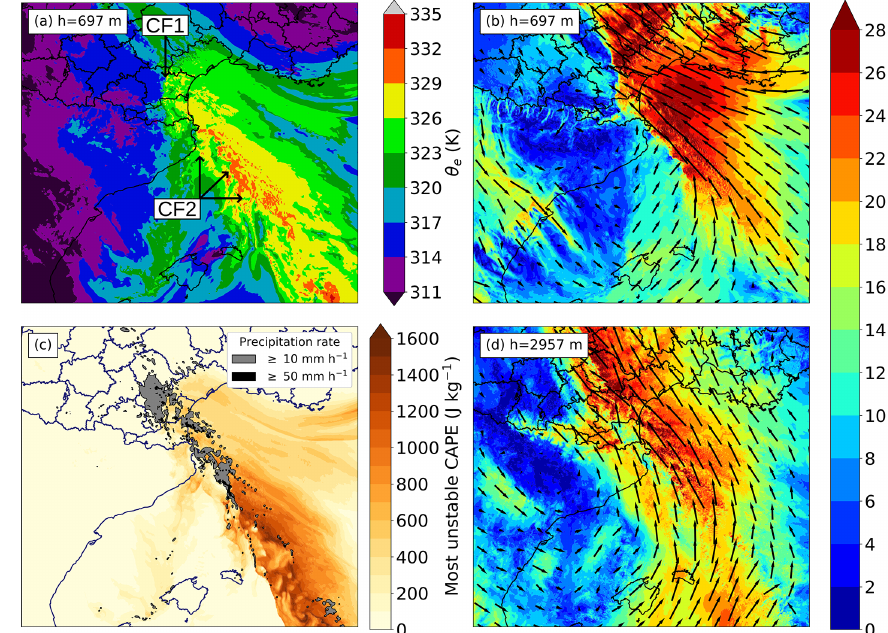
Figure 11. As Fig. 10 at 07:00UTC on 15 October.